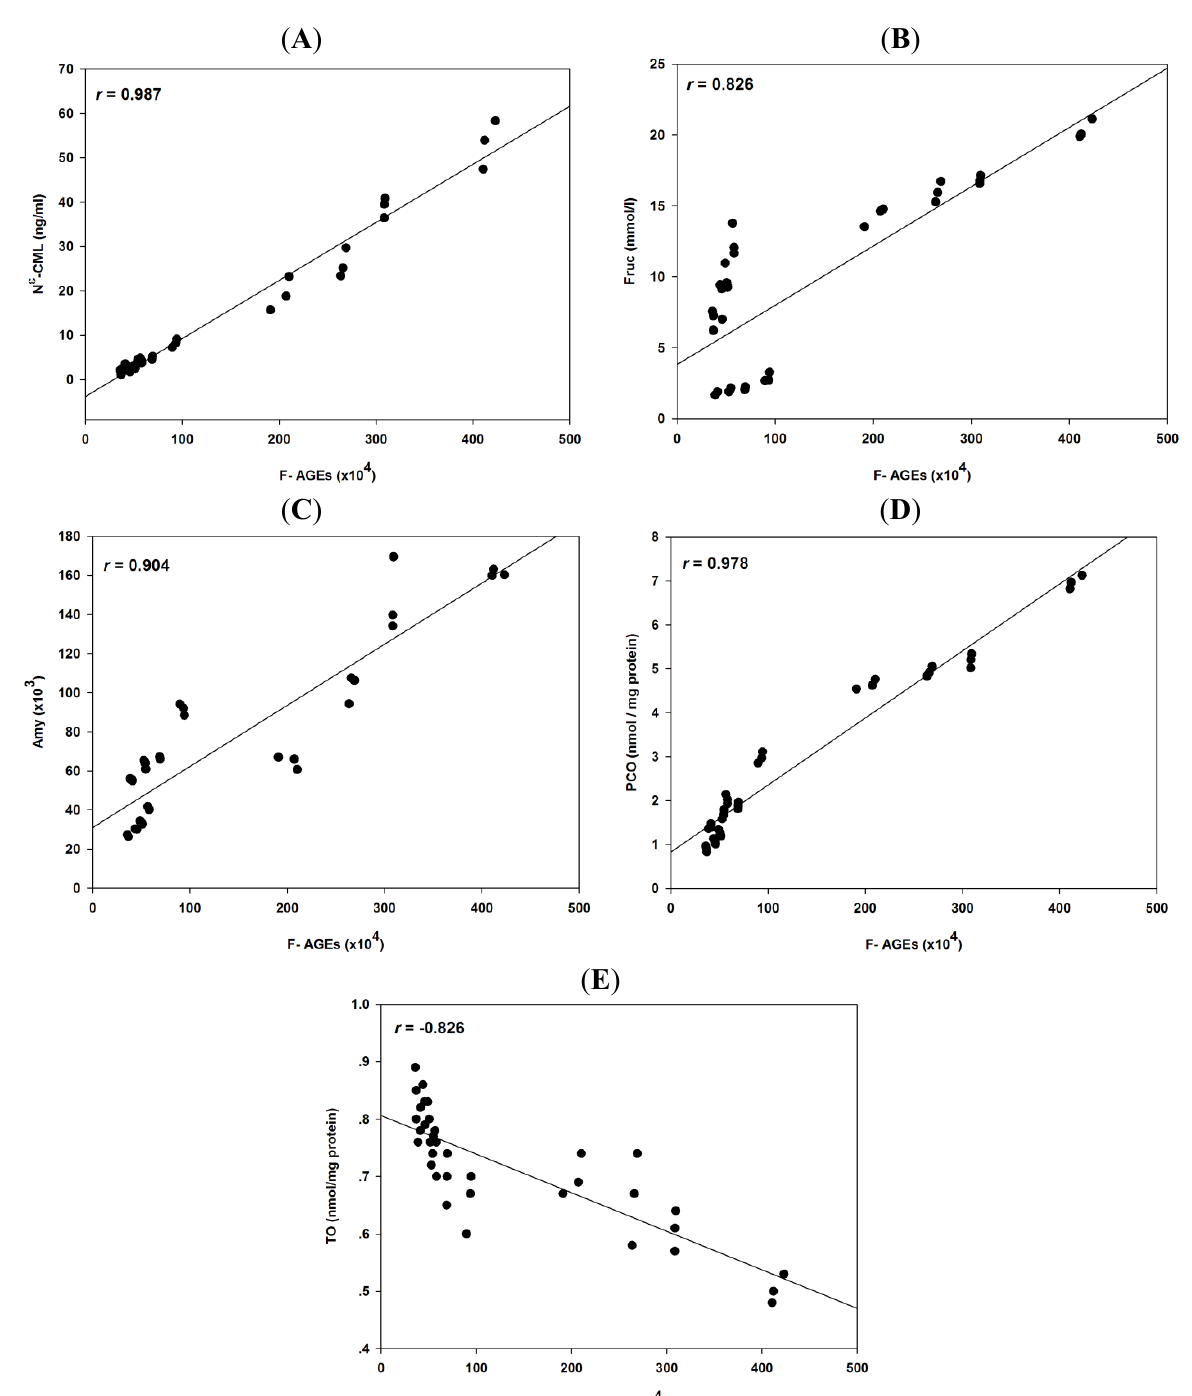
Figure 6. Correlations between fluorescent AGEs (F-AGEs), N ε -CML, fructosamine (Fruc), amyloid cross β -structure (Amy), protein carbonyl content (PCO), and thiol group (TO) in the BSA containing glucose, fructose, and ribose and various concentrations of FA (1–5